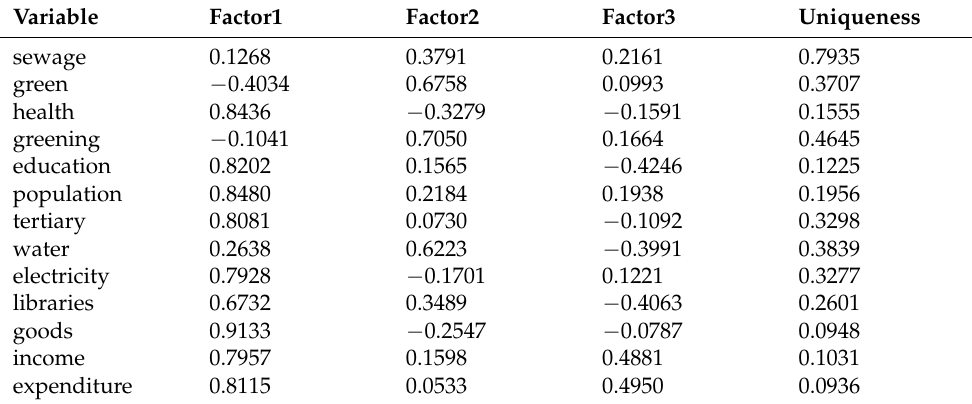
Table 5. Rotating component matrix.